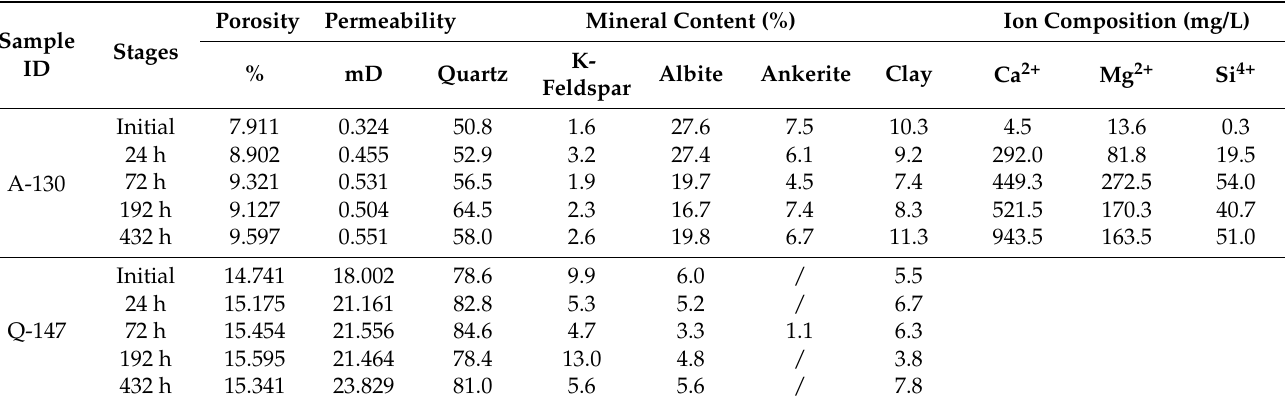
Table 1. Physical properties and mineralogy and ion data of three samples at different